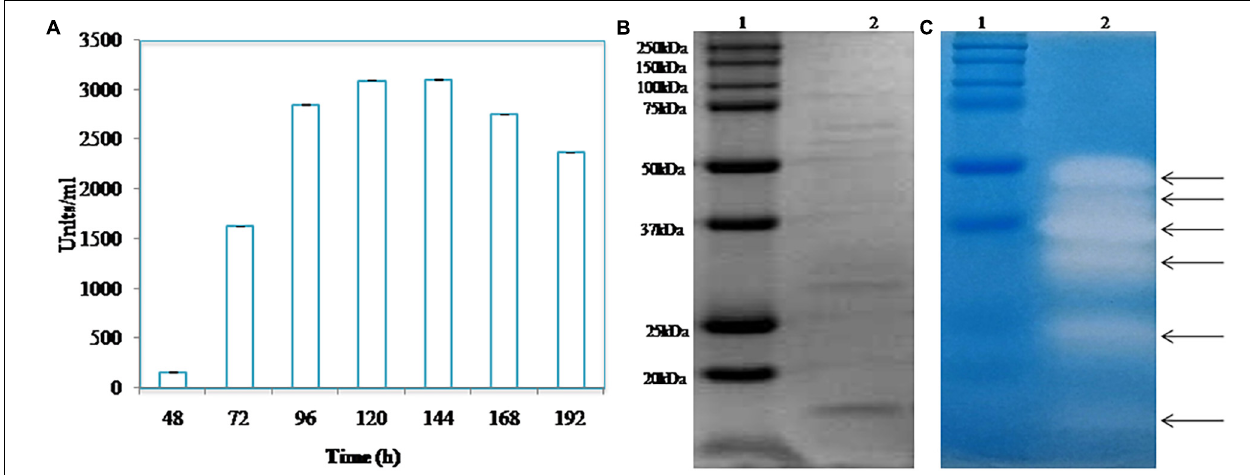
FIGURE 2 | (A) Time course of protease produced by isolate S252 after inoculation. (B) SDS-PAGE analysis of the extracellular protease. (C) Zymogram of caseinolytic activity of extracellular enzyme extract [lane 1, molecular weight marker; lane 2, cell free culture supernatant (CS)].